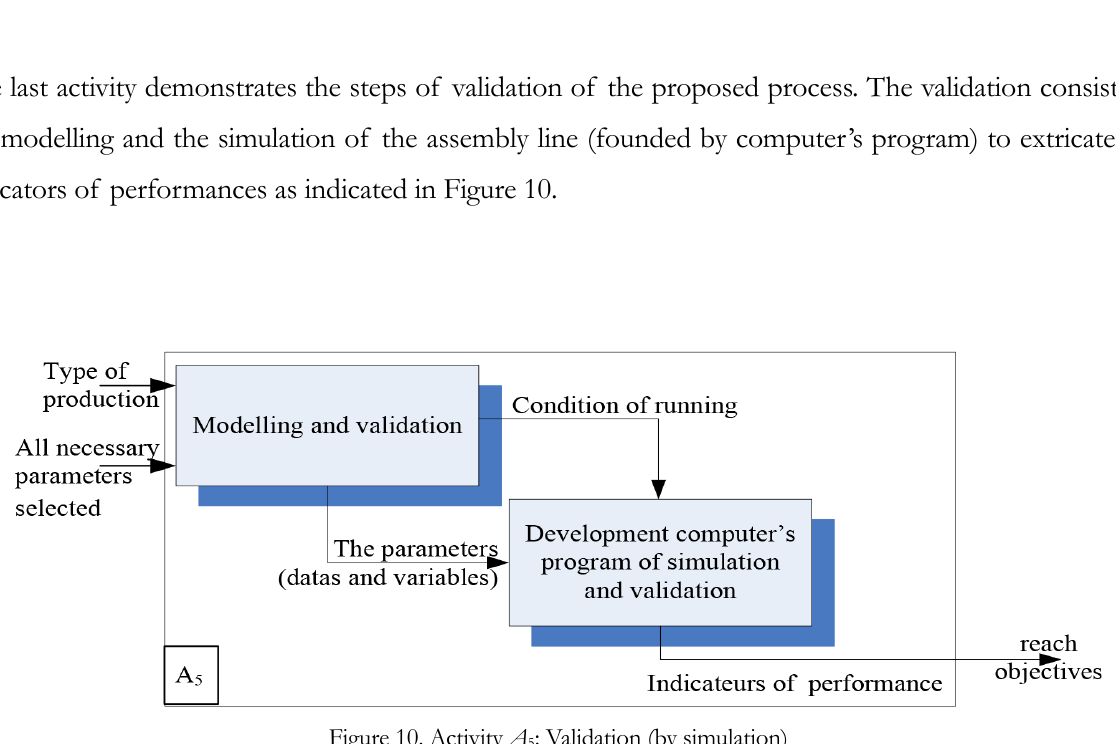
: Configuration of line 4